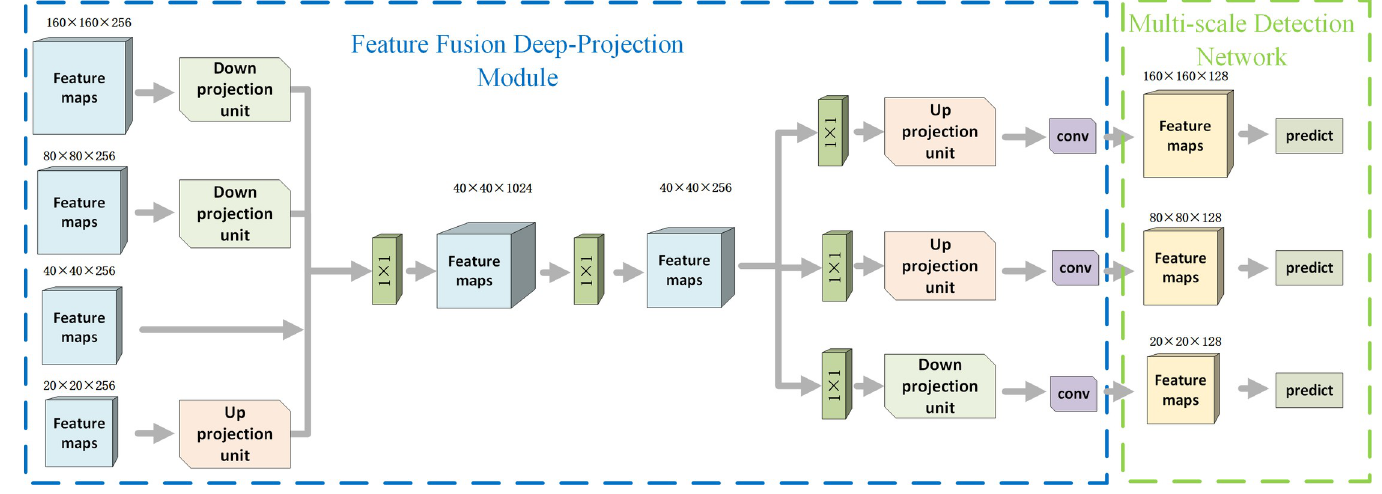
Fig 3. Feature fusion and multi-scale detection